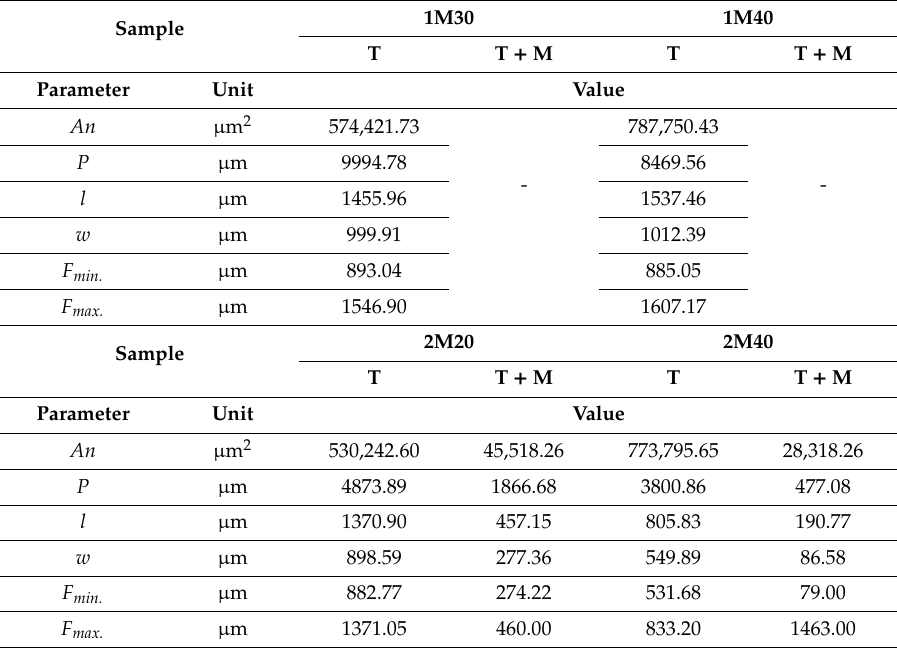
Table 8. Selected geometrical parameters calculated with Media Cybernetics Image Pro ® -Plus 5.1 software, acquired using a three-dimensional (3D) laser microscope Olympus LEXT OLS4000 image of the grinding wheel active surface (GWAS) from Figure